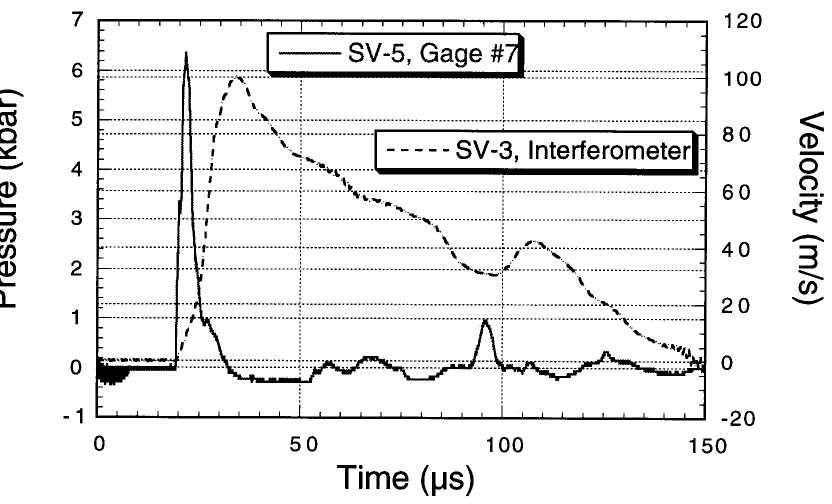
Fig. 3. Midplane comparison of pressure (Shot SV-5) and wall velocity (Shot